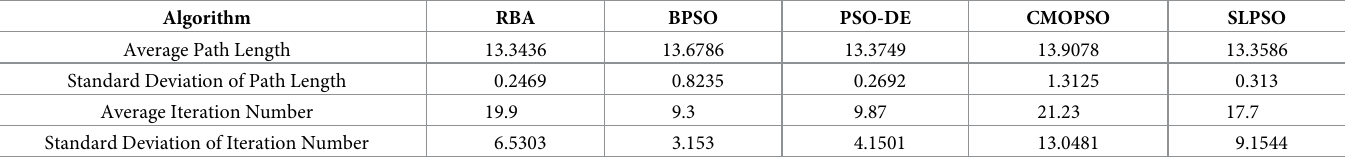
Table 5. Performance comparison between RBA and PSO variants in test case